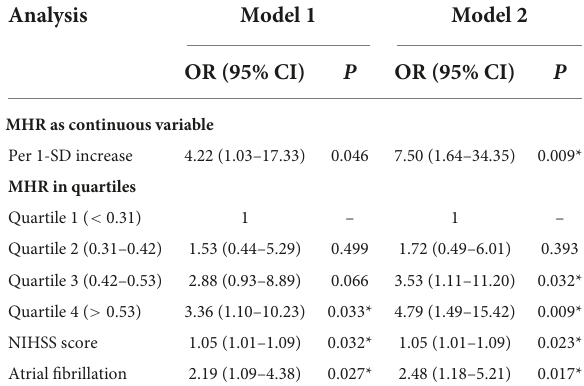
TABLE 4 Multivariate logistic regression to assess the potential relationship between monocyte to high-density lipoprotein ratio (MHR) and hemorrhagic transformation (HT).